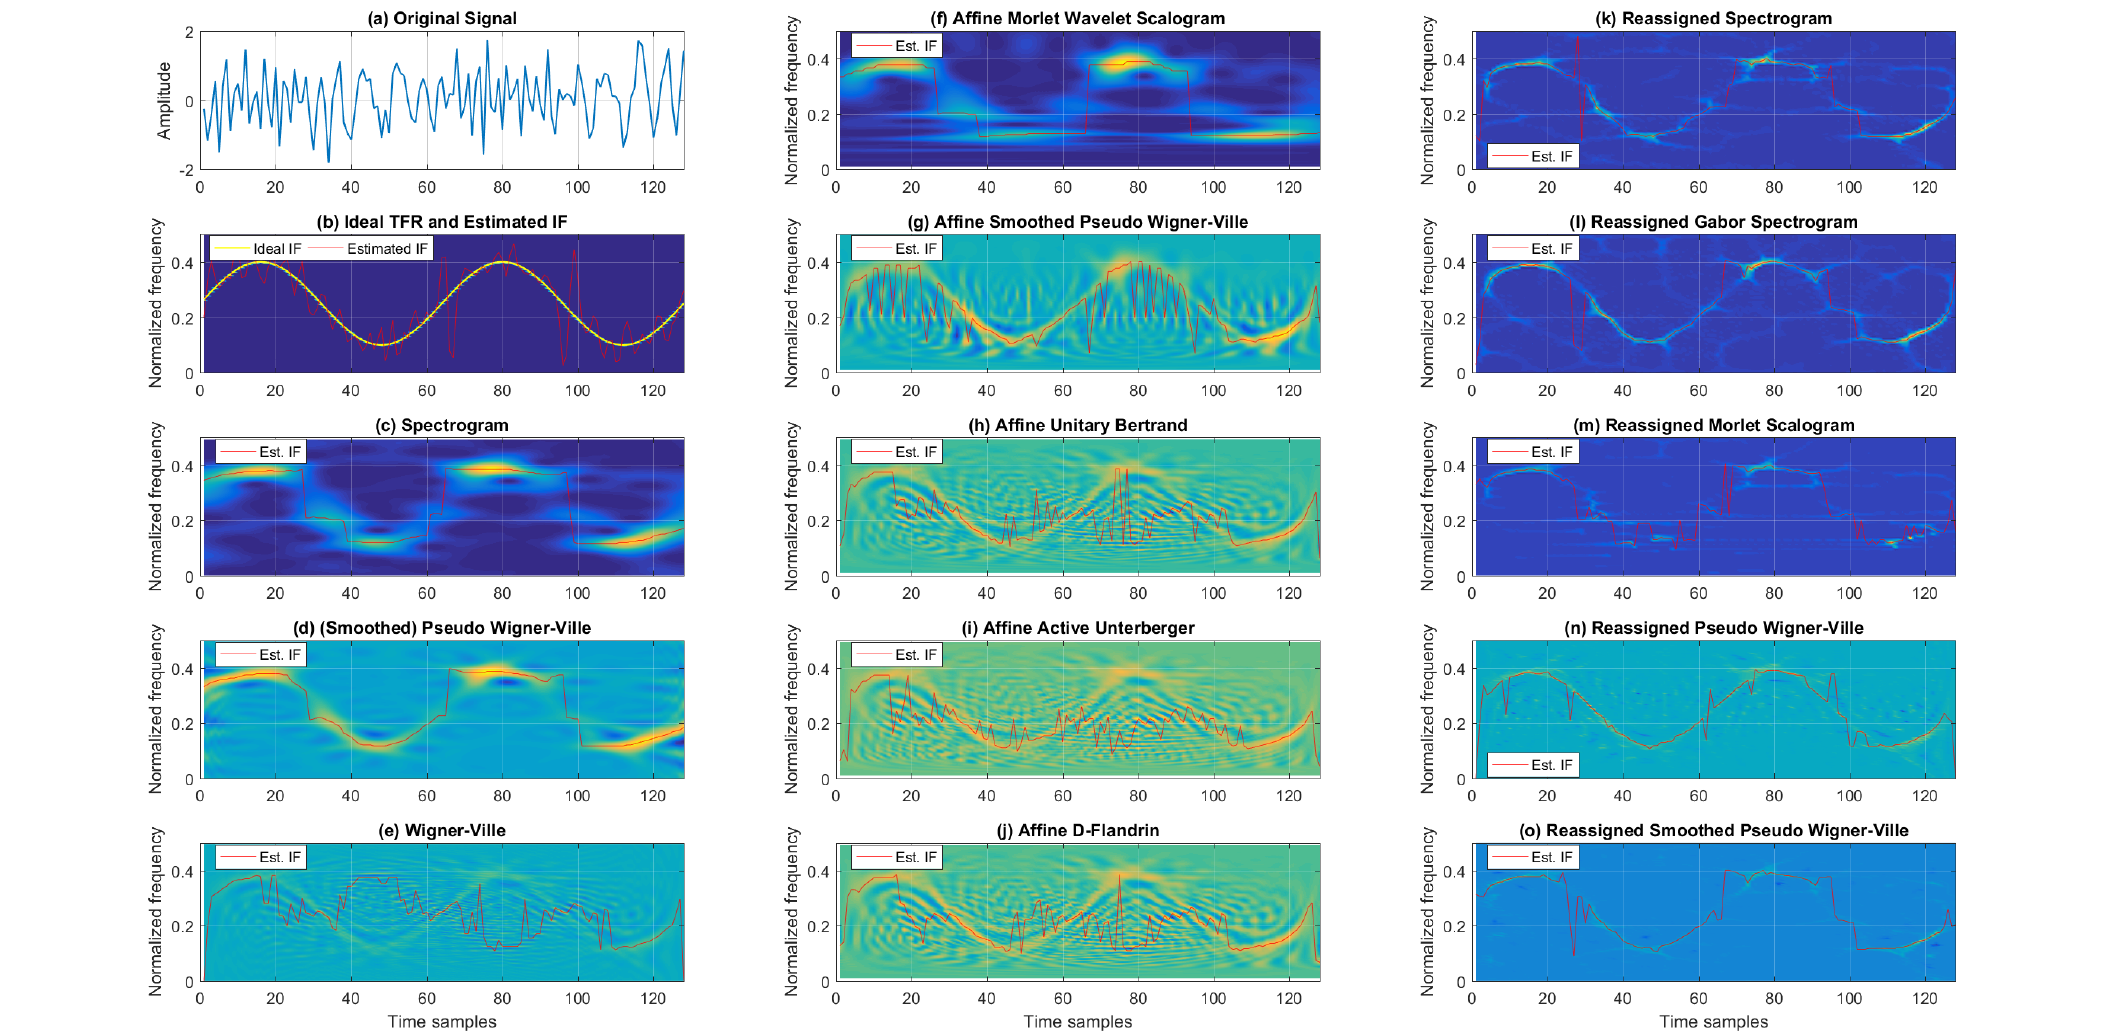
Figure 4. TFRs of a noisy mono-component sinusoidal FM signal with estimated IFs for the SNR of 5